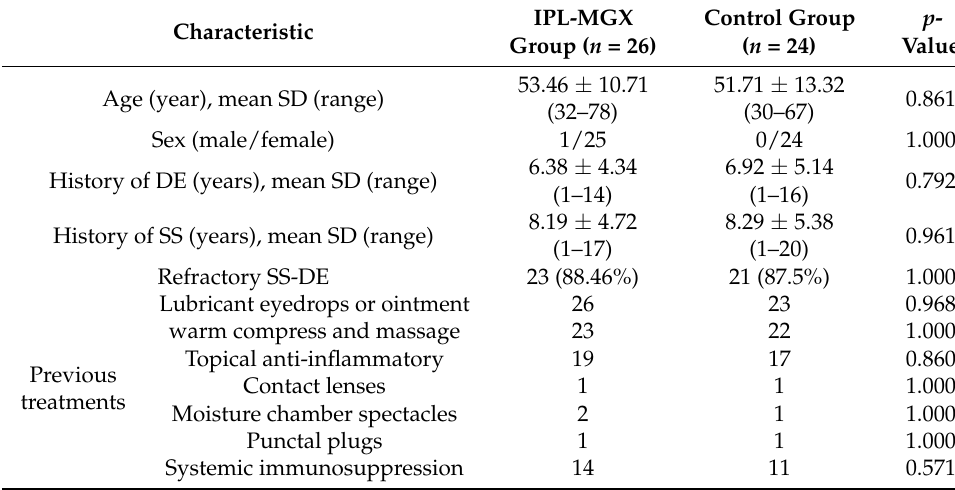
Table 1. Characteristics of the study subjects in the intense pulsed light (IPL) ‐ meibomian gland ex ‐ pression (MGX) and control groups.